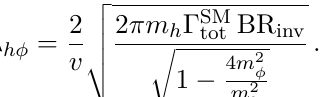
for each mass. hφ and by the lifetime, respectively. h → φφ